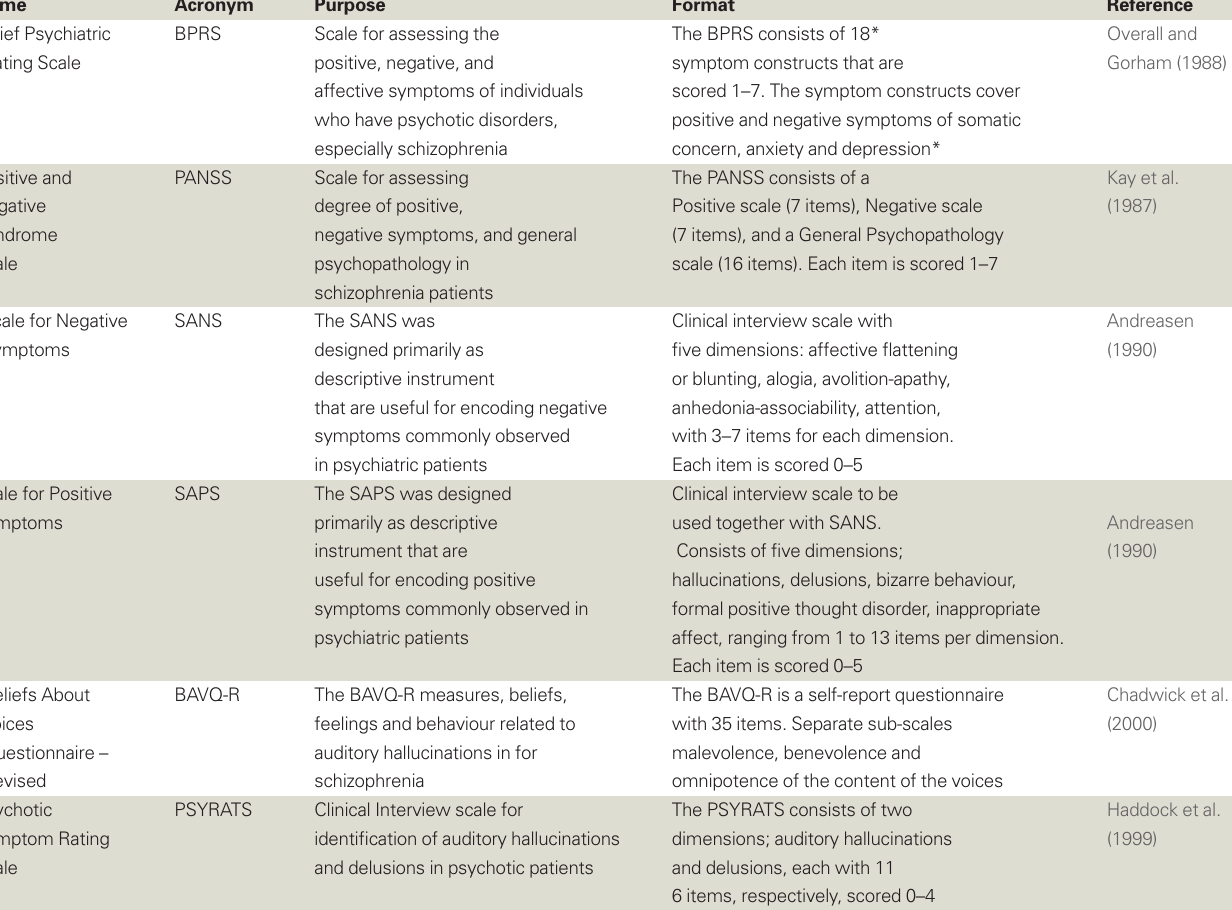
Table 1 | An overview of symptom scales described earlier, with names, acronyms, and a brief description of purpose and format of each